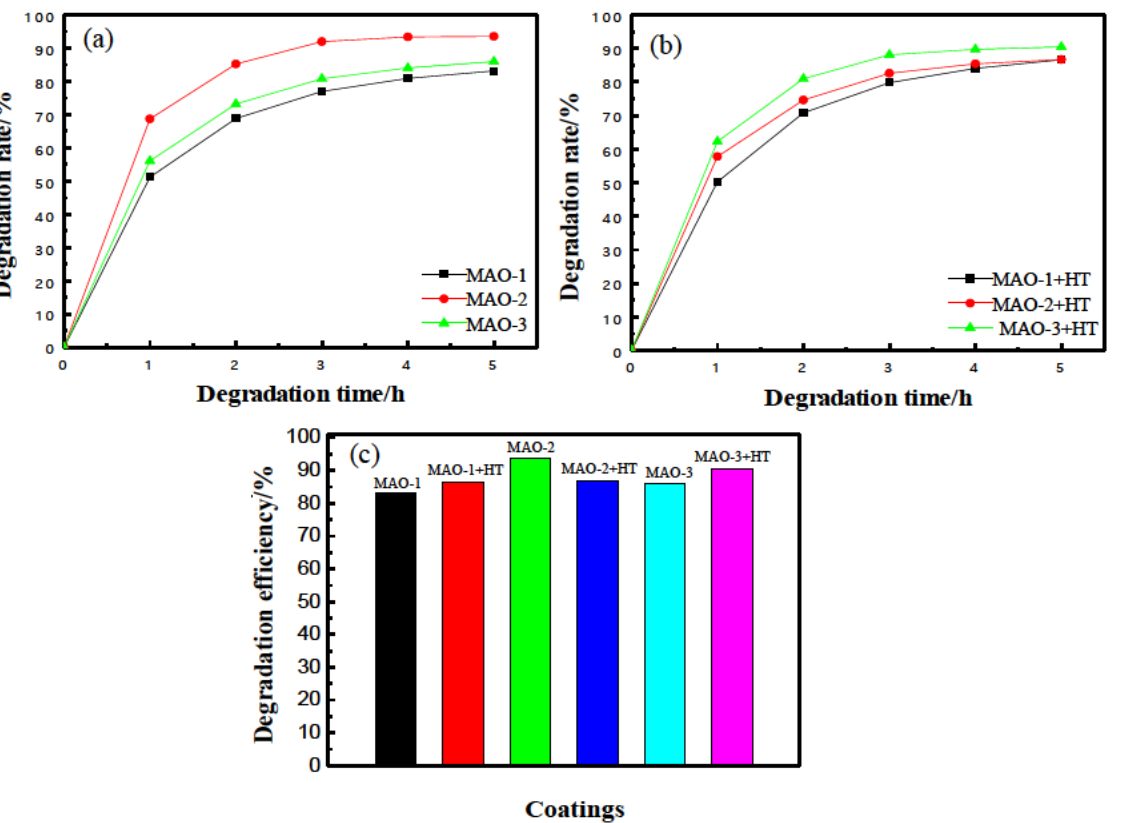
Figure 5: Photocatalytic activity of three MAO coatings (a) before heat treament, (b) after heat treatment, (c) catalytic effect of MAO coatings for 5